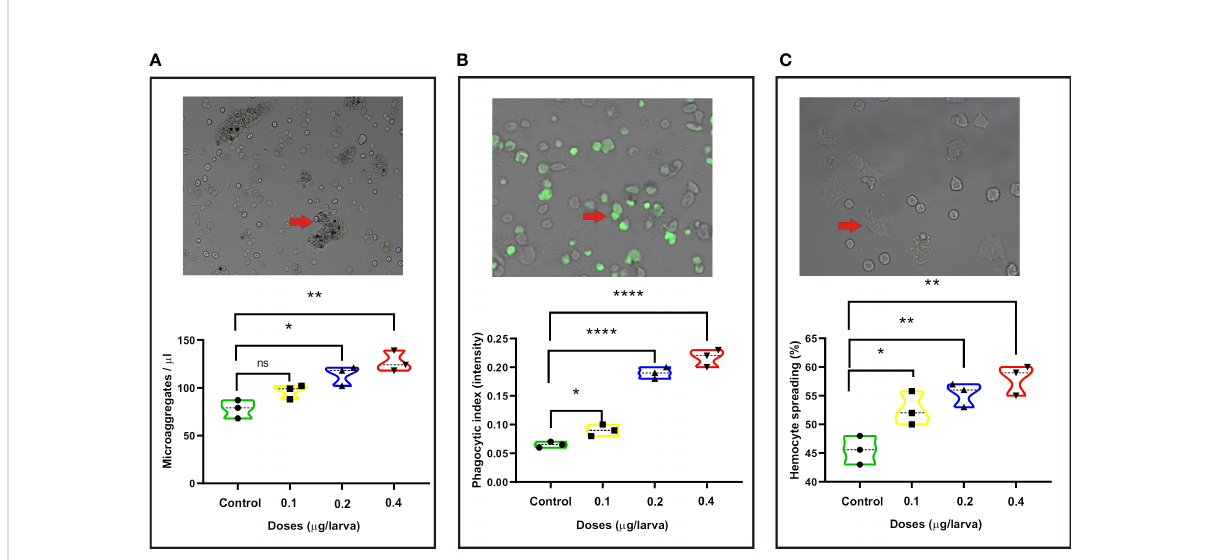
FIGURE 1 Changes in the following innate immune parameters of silkworm at 24 h after injection with different doses of Poria cocos polysaccharides (PS). (A) Microaggregate numbers. (B) Phagocytic index. (C) Hemocyte spreading. The average values calculated from three independent experiments and the statistical differences between the treatment and the control groups are displayed with an asterisk (*). * P < 0.05, ** P < 0.01, **** P ≤